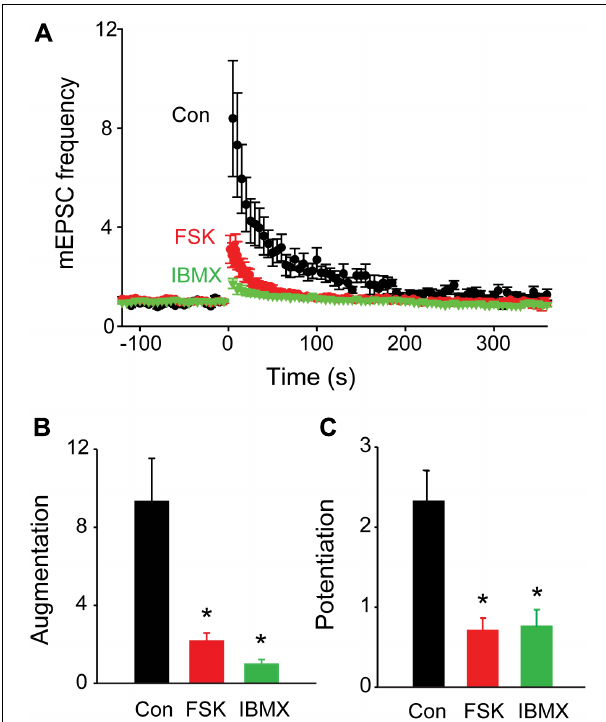
FIGURE 6 | Occlusion of synaptic plasticity following elevation of presynaptic cAMP levels. (A) Time course of changes in normalized mEPSC frequency produced by electrical activity (50 Hz, 2 s stimulation) in TWT neurons in control conditions (black), as well as in the presence of forskolin (FSK; 10 µ M; red) and IBMX (green). Points indicate mean values of mEPSC frequency ( n = 5), normalized to baseline values measured prior to the stimulus train, and error bars indicate ± SEM. (B) Peak amount of augmentation of mEPSC frequency, calculated from exponential fits to the data in panel (A) , in control (black), forskolin (red), and IBMX (green). (C) Amount of potentiation of mEPSC frequency in same conditions described in panel (B) . Values in panels (B,C) indicate means and error bars indicate ± SEM, while asterisks indicate significant differences between control and forskolin or control and IBMX.